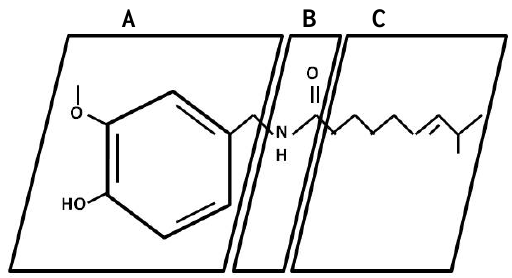
Figure 1. Regions of the molecule of capsaicin. A (aromatic ring); B (amide bond); and C (hydrophobic side